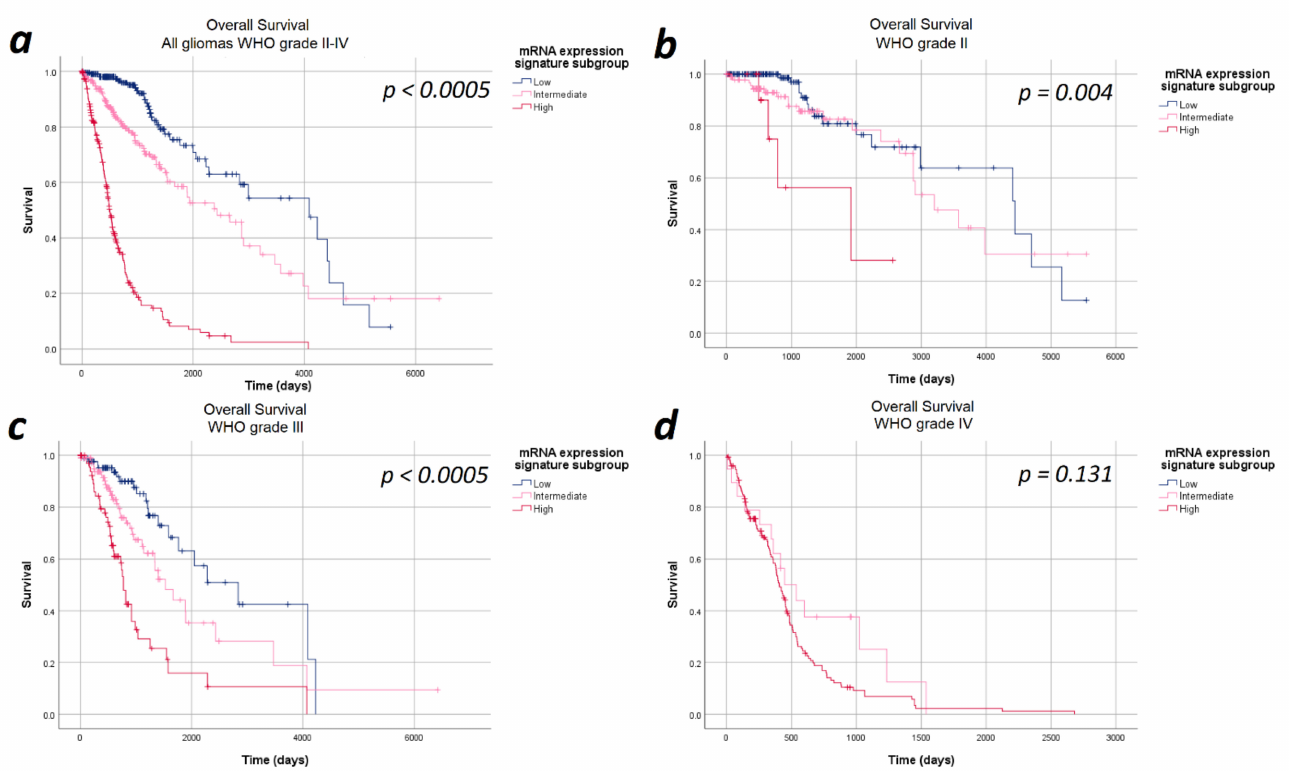
Figure 2. Kaplan–Meier curves of overall survival stratified by heme biosynthesis mRNA expression signature subgroups. ( a ) All gliomas WHO grades II–IV: The overall survival differed significantly between the mRNA expression signature subgroups in the entire study cohort. ( b ) In WHO grade II and ( c ) WHO grade III gliomas significant differences in the overall survival between the mRNA expression signature subgroups were found. ( d ) WHO grade IV gliomas: No statistically significant difference in the overall survival between the mRNA expression signature subgroups was observed in WHO grade IV